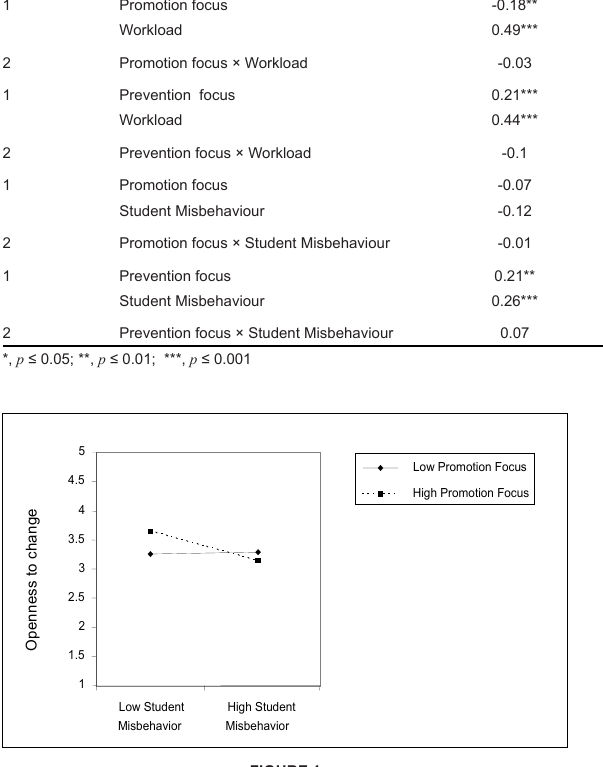
FIGURE 1 Promotion focus moderating the relationship between student misbehaviour and openness to change in sample